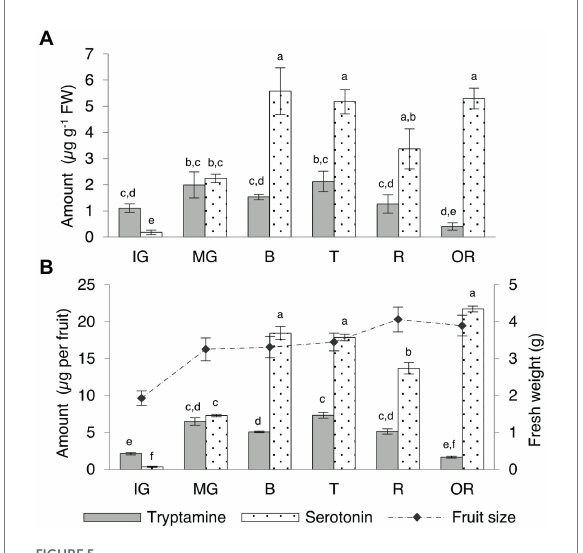
FIGURE 5 Quantities of tryptamine and serotonin detected by UPLC-ESI-MS in Micro-Tom fruits at different developmental and ripening stages expressed as (A) μ g g − 1 FW and as (B) μ g per whole berry. Data are means ± SD ( n = 3). Different letters on bars indicate that means are significantly different according to post-hoc Tukey- ANOVA ( p < 0.05). The abbreviations and the position of the samples are explained in Figure